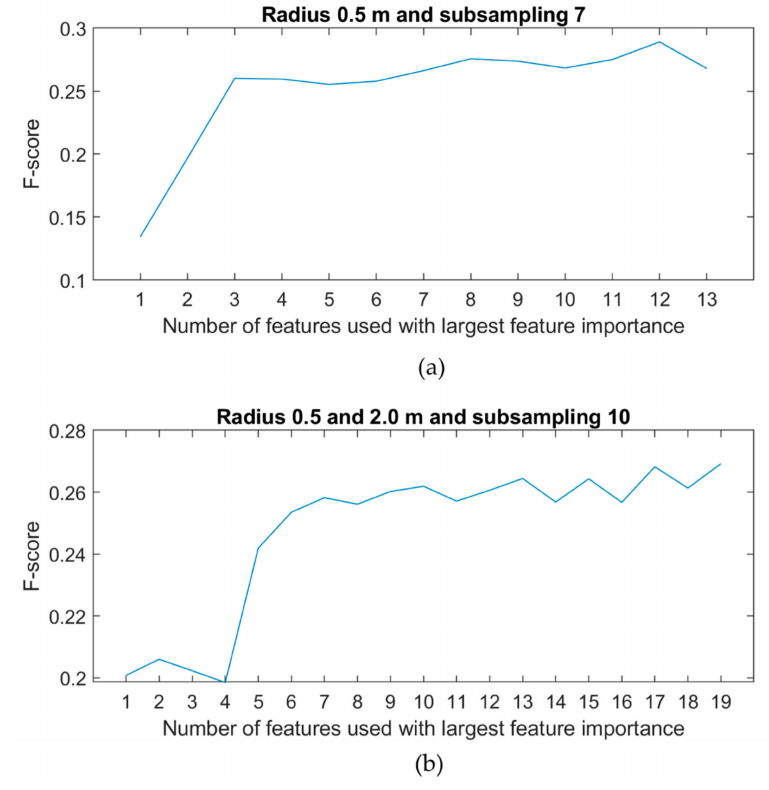
Figure 11. Test of all best feature thresholds for ( a ) radius 0.5 m and subsampling 7 and ( b ) for radius 0.5 m and 2.0 m and subsampling 10.